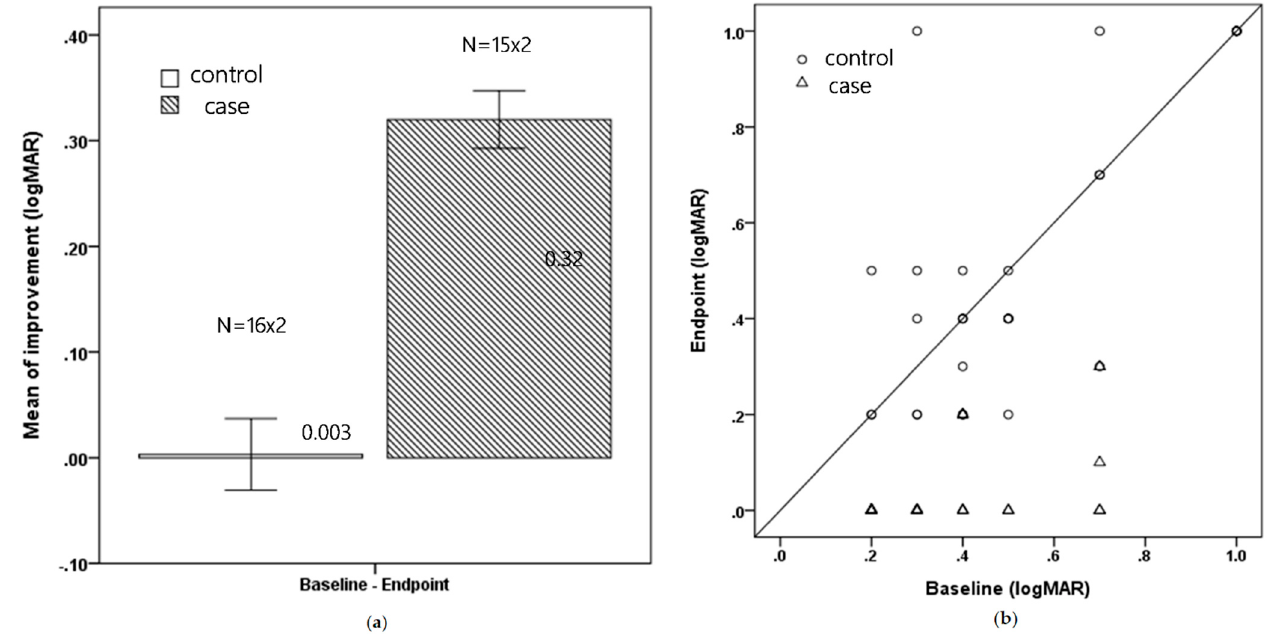
Figure 1. ( a ) Mean improvement in BCVA for the control and treatment groups (logMAR) (Mean ± Standard error) ( b ) The total change in BCVA for each patient (logMAR).